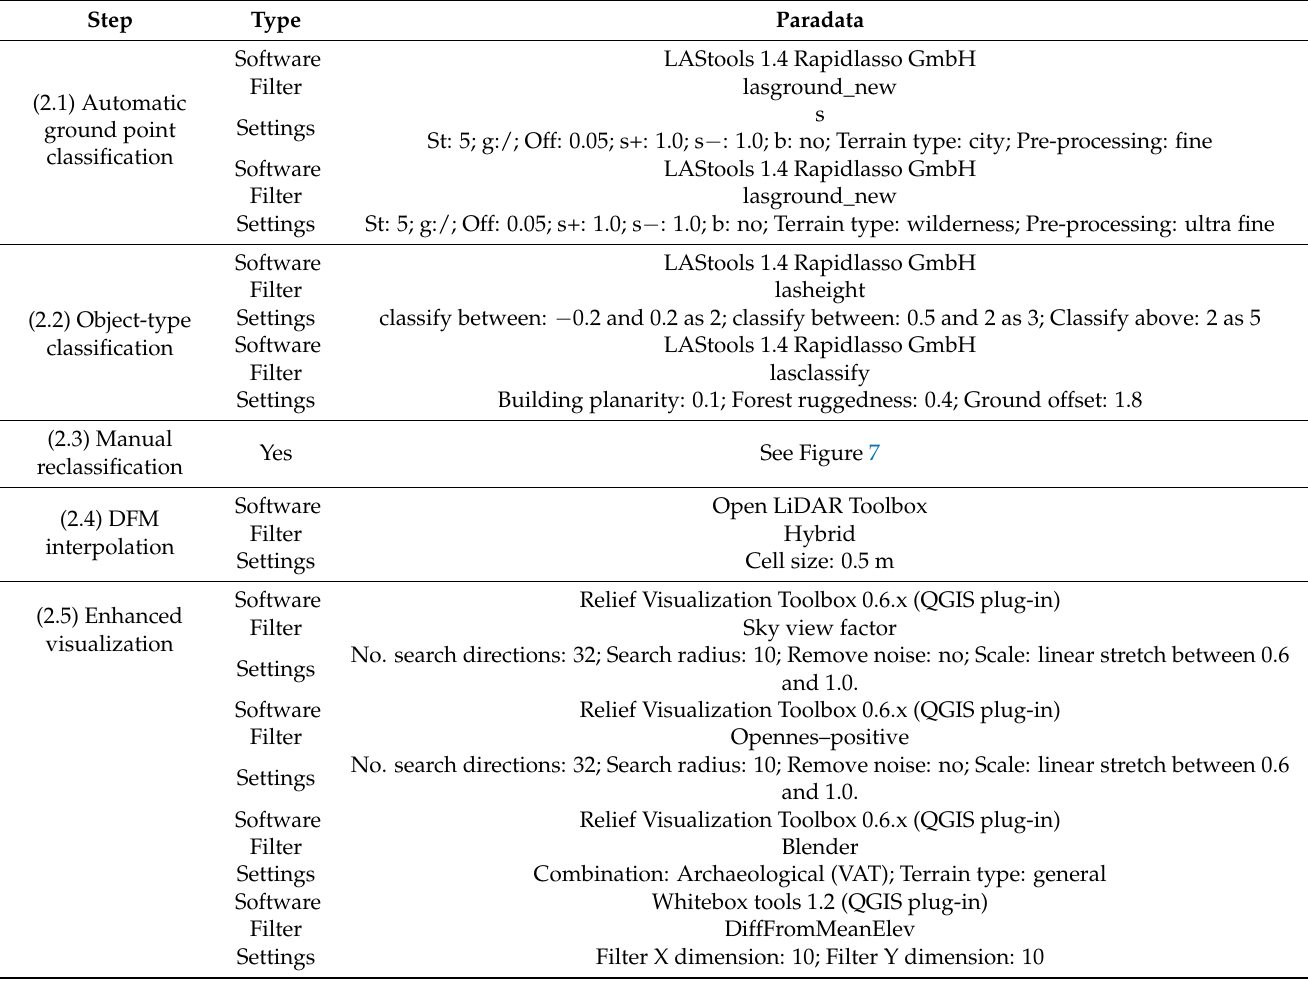
Table 5. Paradata for the proposed pipeline as implemented with Open LiDAR Toolbox tool One (paradata structure after [5]). Since the One only calls different tools, the original software packages are